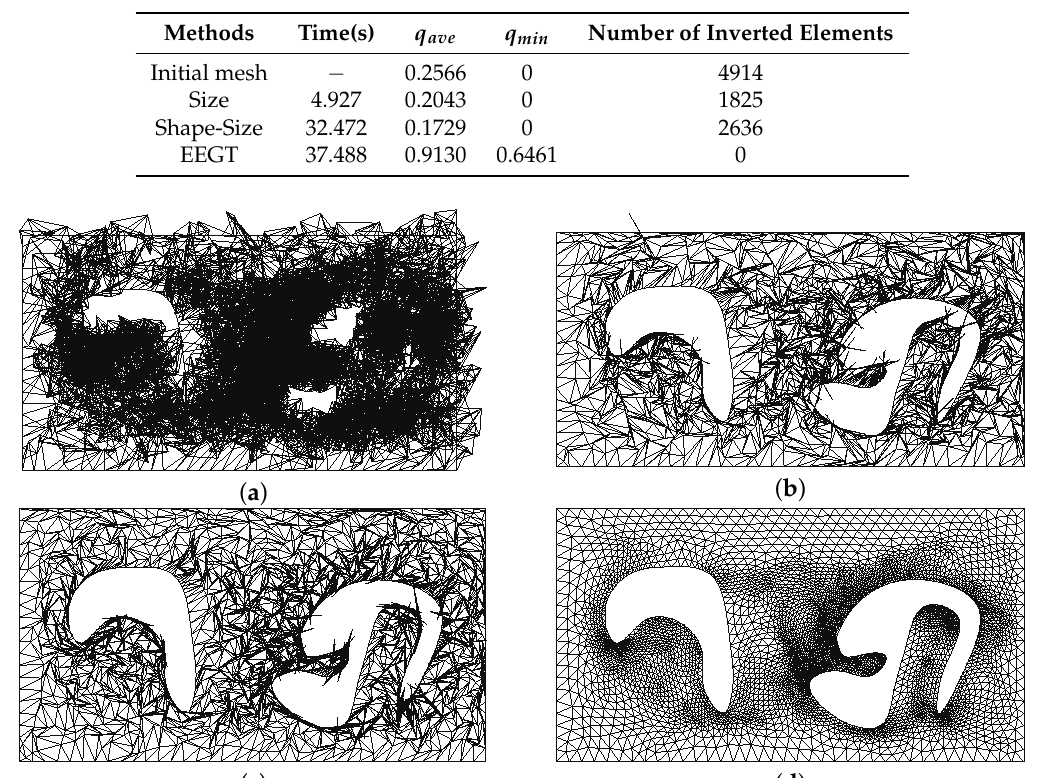
Figure 8. ( a ) Initial triangular mesh with 4914 inverted elements. ( b ) Optimized mesh using the Size untangler. ( c ) Optimized mesh using the Shape-Size untangler. ( d ) Optimized mesh using the proposed